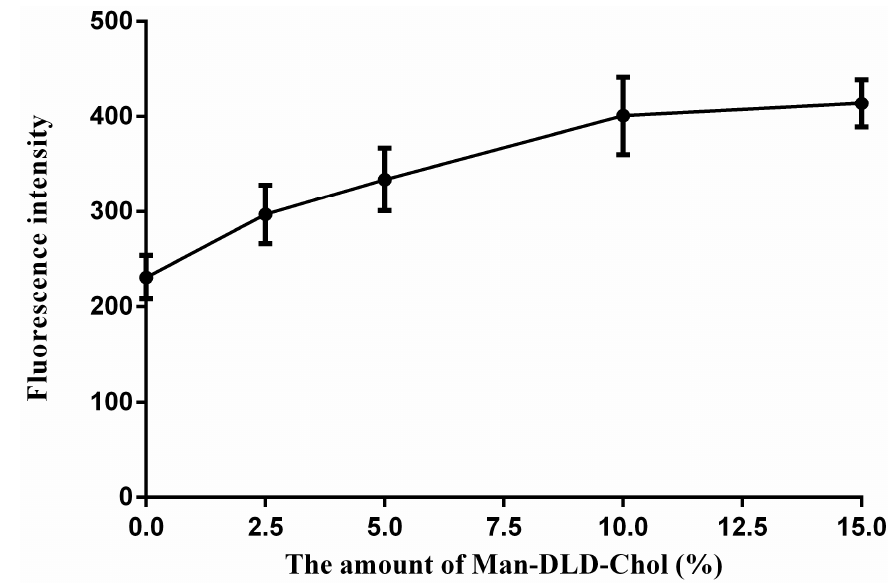
Figure 5. In vitro cellular uptake of Man-DLD-Chol-C 6 -Lp.